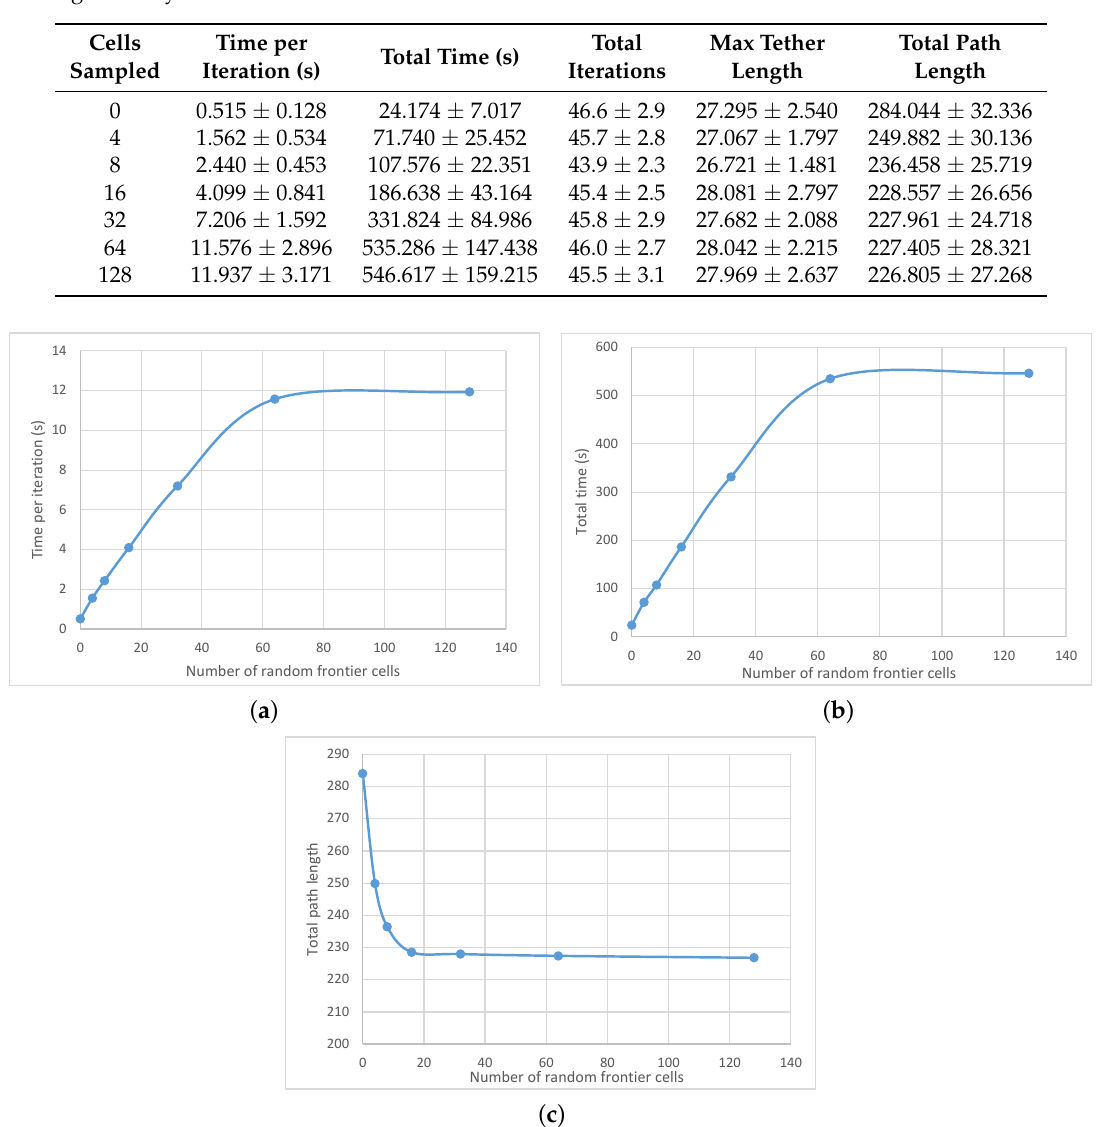
Figure 5. Illustration of the data from Table 5. The effect of the number of random frontier cells on time per iteration ( a ), total computation time ( b ) and total path length ( c